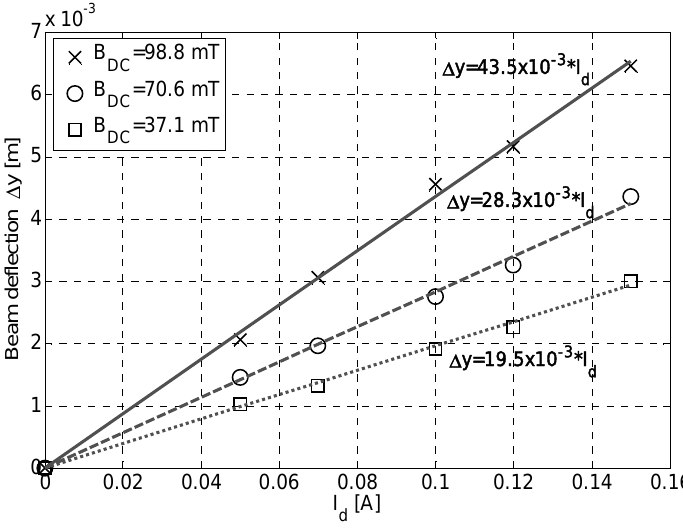
Figure 6. The beam deflection as function of the driving current.